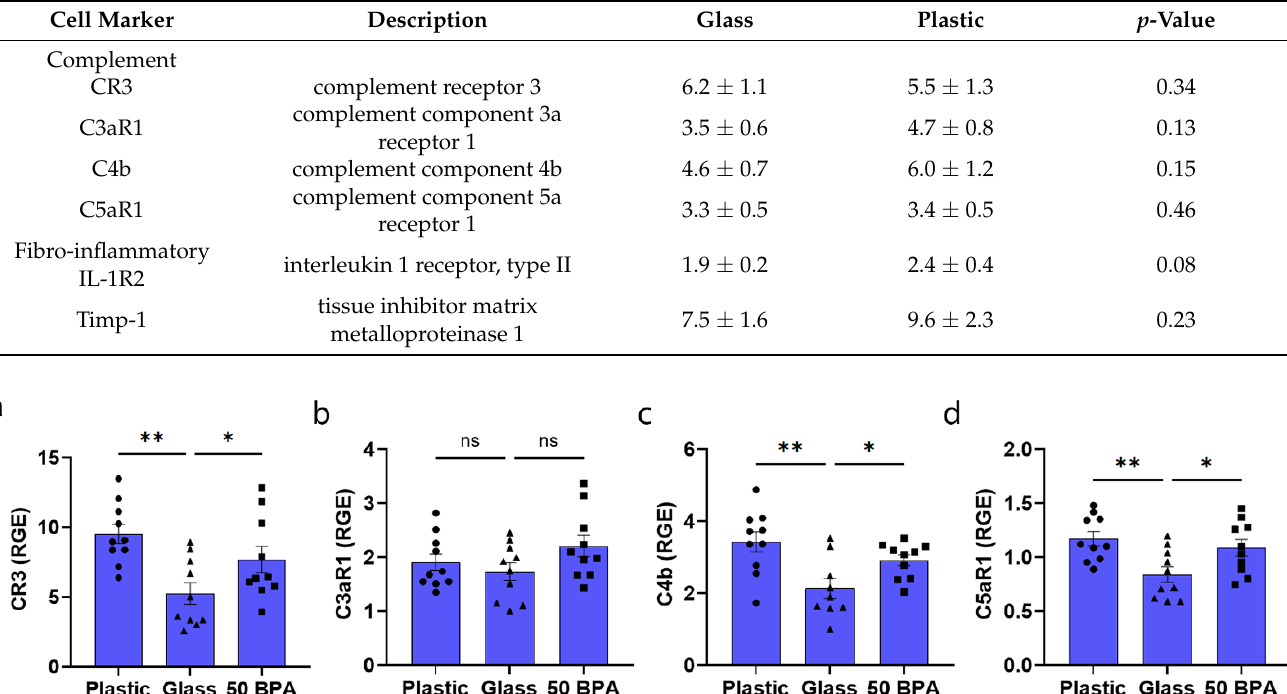
Figure 12. Plastic caging increases complement markers in males with myocarditis, but not in females . Male (blue) BALB/c mice were given normal drinking water (drinking water that did not contain BPA) for 2 weeks and housed either in glass cages/water bottles (glass) or plastic cages/water bottles (plastic) with soy-free food and bedding. BALB/c mice housed in glass cages/water bottles with soy-free food and bedding were given either normal drinking water (drinking water that did not contain BPA) (0 BPA/glass) or 250 μ g BPA/L water (50 BPA) for 2 weeks. Mice were injected i.p. with 10 3 PFU of CVB3 on day 0 and harvested at day 10 pi. Relative gene expression (RGE) was used in whole hearts by qRT-PCR to assess ( a ) complement receptor 3 (CR3), ( b ) complement component 3 antagonist receptor 1 (C3aR1), ( c ) complement component C4b, or ( d ) complement component 5 antagonist receptor 1 (C5aR1), compared to the housekeeping gene Hprt. Data shown as scatter plot and mean +/−SEM using one-way ANOVA with Holm –Šídák’s multiple comparisons test with 10 mice/group (* p < 0.05), (** p < 0.01). Table 1. Effect of plastic vs. glass caging on female mice on expression of complement and fibro-inflammatory markers in the heart using qRT-PCR.